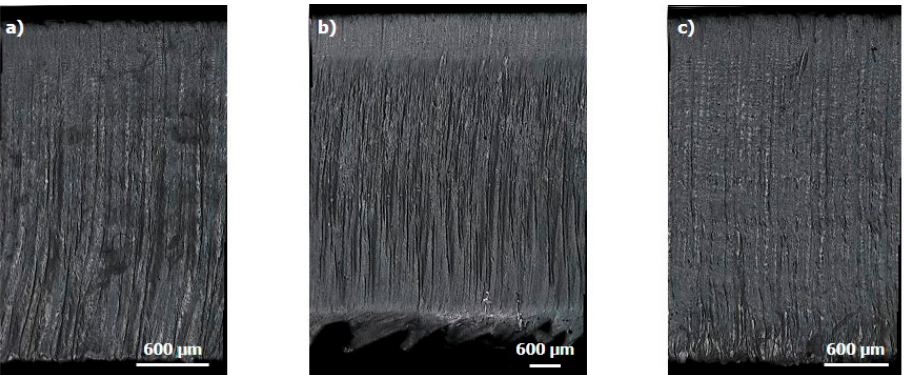
Figure 21. AlMg3 kerf lateral surface: ( a ) 6 mm, Cs = 100% P = 100%; ( b ) 6 mm, Cs = 50% P = 100%; ( c ) 4 mm, Cs = 50% P = 100%.